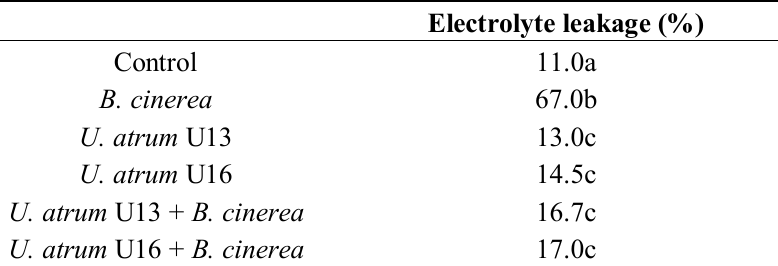
Table 1. Percent of electrolyte leakage 4 days post inoculation of grapevine ( V. vinifera L.) leaves. Leaves were challenged with B. cinerea 3 days after being inoculated with U. Atrum